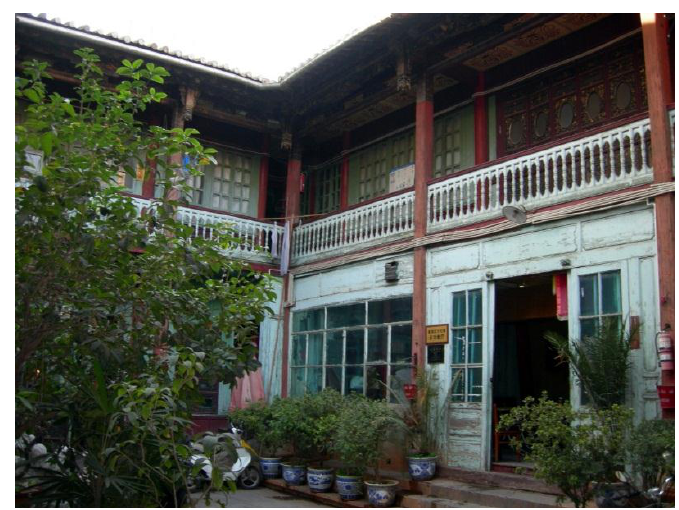
Figure 1. A courtyard house in